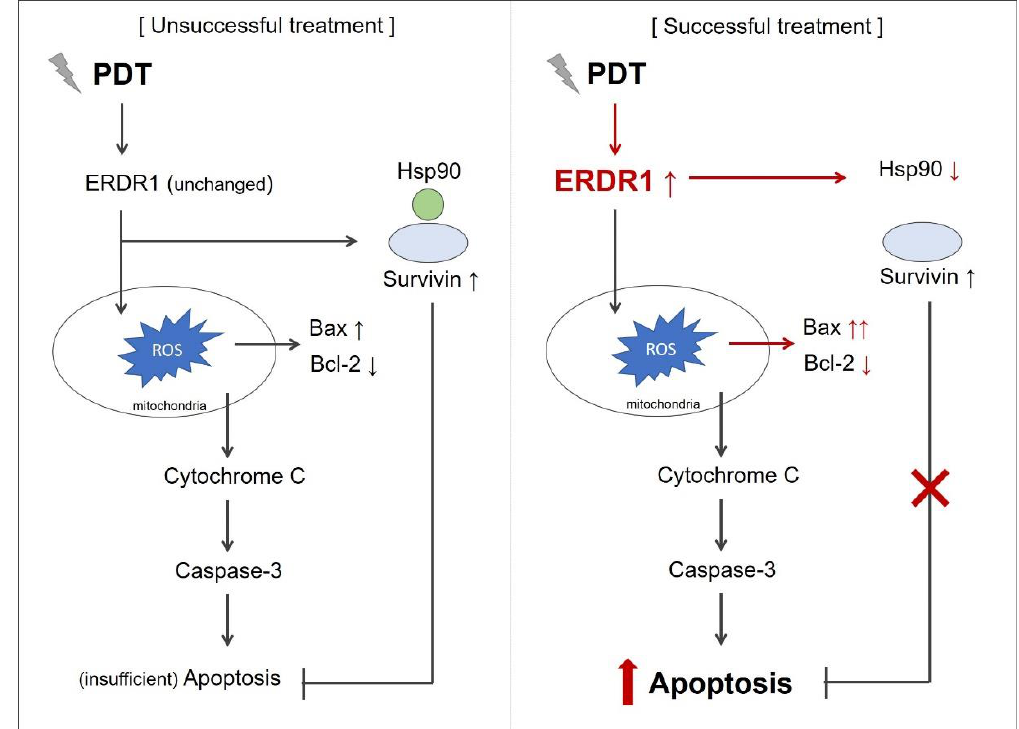
Figure 2. Schematic picture of photodynamic therapy (PDT) response mediated by ERDR1. In the case of unsuccessful treatment, the ERDR1 expression level after PDT was not changed after PDT. Survivin increased by PDT is one reason to show insu ffi cient apoptosis. As shown in the successful treatment case, the increased expression of ERDR1 after PDT may reduce the Hsp90 expression, resulting in the inhibition of surviving / Hsp90 complex formation. In addition, the recovery of ERDR1 may increase the Bax / Bcl-2 ratio to activate caspase-3. Altogether, ERDR1 is suggested as a key factor of PDT-mediated apoptosis to improve PDT